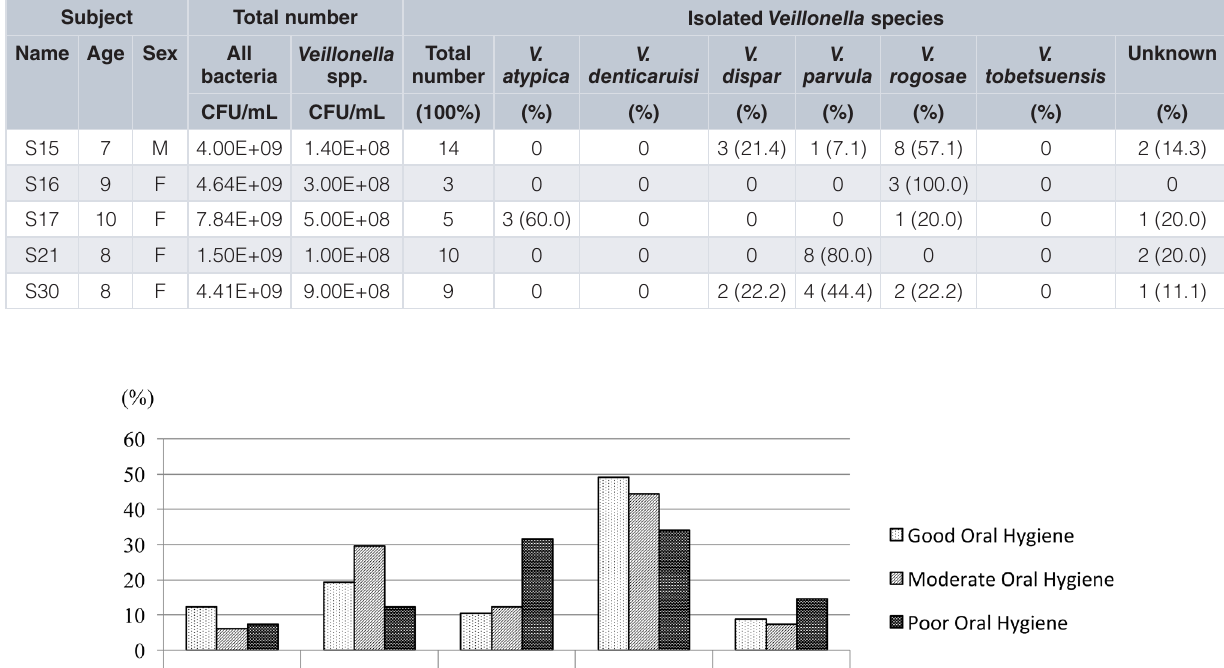
Table 3. Ratio of the number of isolates of each species to the total number of Veillonella isolated in saliva from the poor oral hygiene group. The colony-forming units (CFU) of all anaerobic bacteria on the brain heart infusion agar and Veillonella strains on Veillonella agar (detection limit <0.1% of the total count). The total of Veillonella isolates identified by the Veillonella genus-specific PCR primer. Individual species as a percentage of the number of isolates identified by one-step PCR with the species-specific primer sets for each subject ( n =5) from saliva of the poor oral hygiene group.